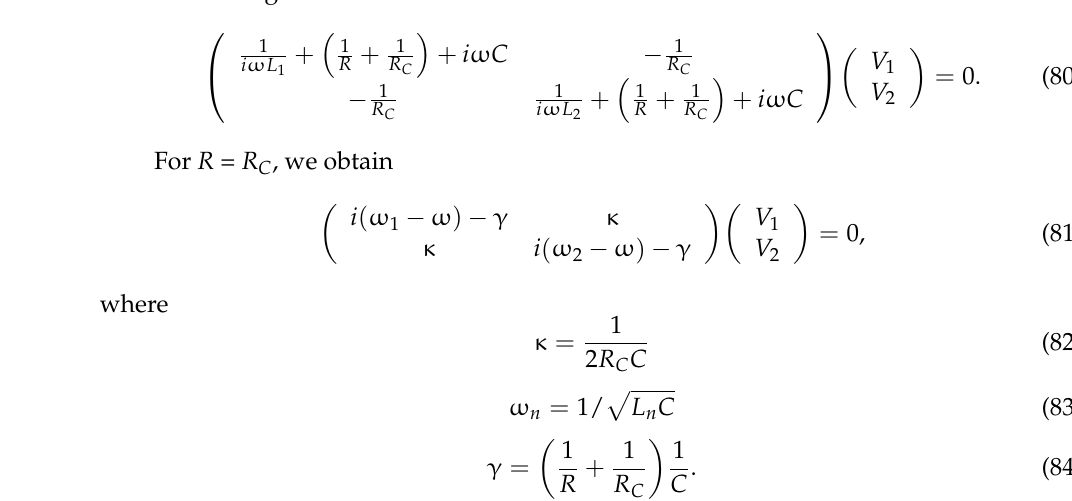
Figure 12 schematizes the idea of two coupled resonators for anti-PT symmetry proposed in [76].